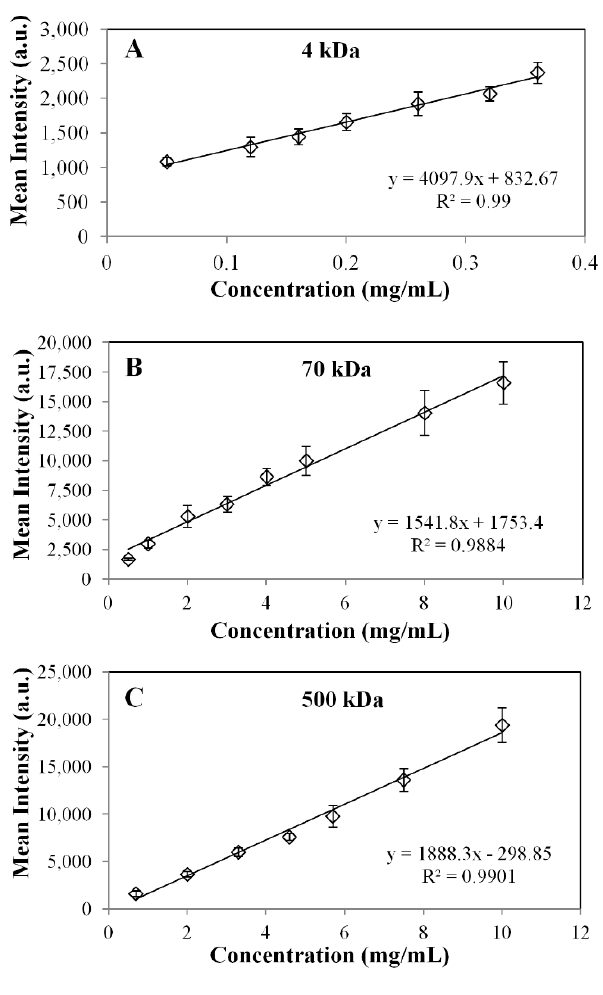
Figure 5. Sample calibrations curve for the FITC MW probes: ( A ) 4 kDa; ( B ) 70 kDa; and ( C ) 500